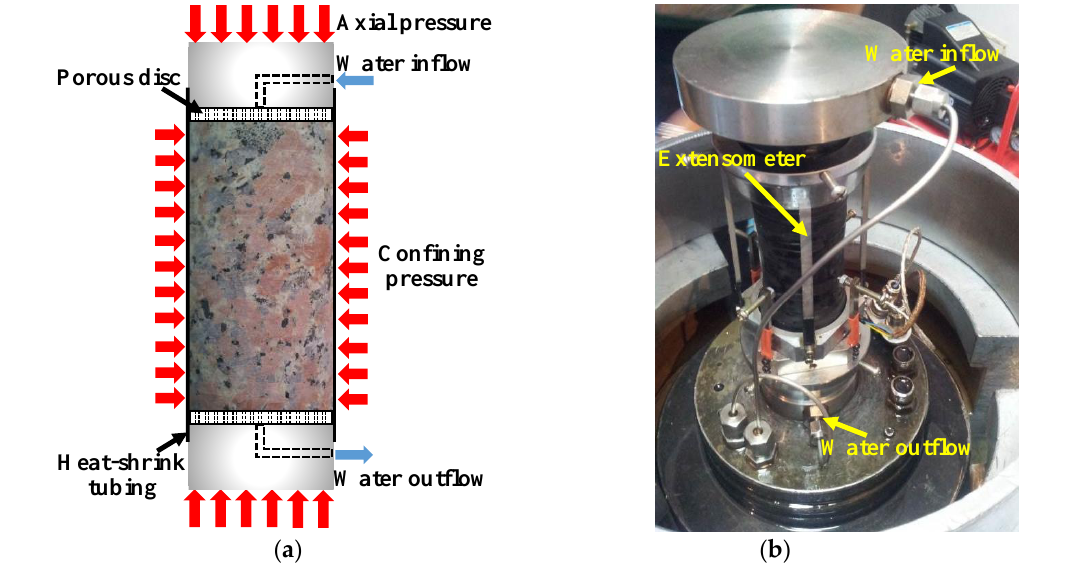
Figure 3 . ( a ) Sketch of the experimental method; ( b ) Setup for the hydro-mechanical experiment. Figure 3. ( a ) Sketch of the experimental method; ( b ) Setup for the hydro-mechanical